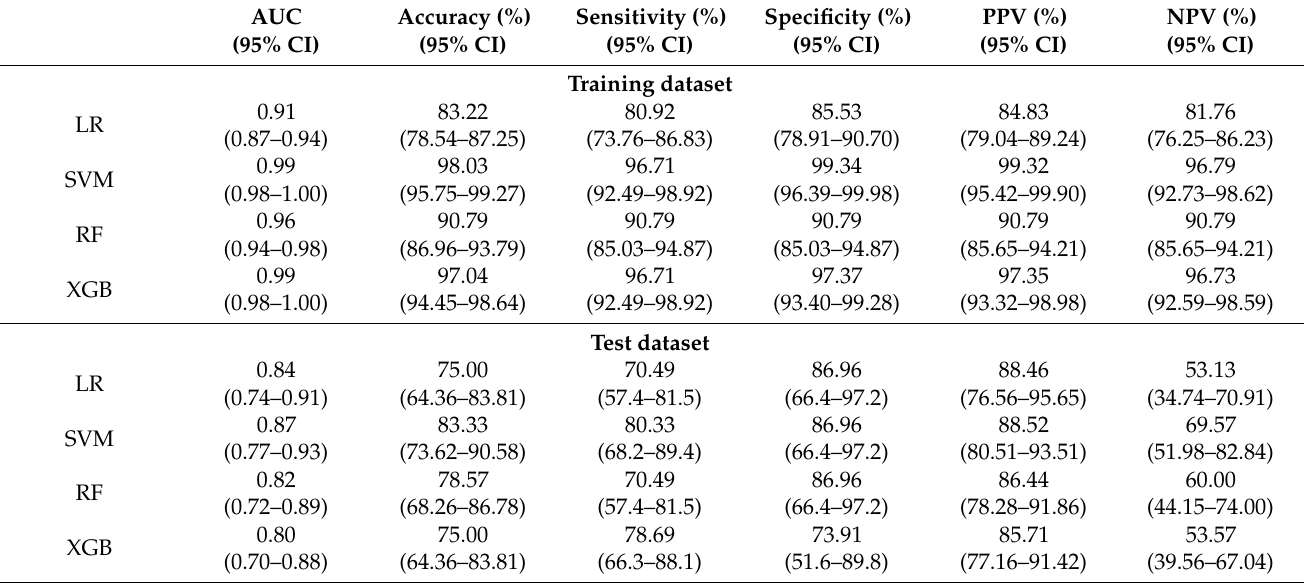
Table 3. The observed AUC, accuracy, sensitivity, specificity, PPV, and NPV for OSA prediction of each machine learning model for the training and test data.